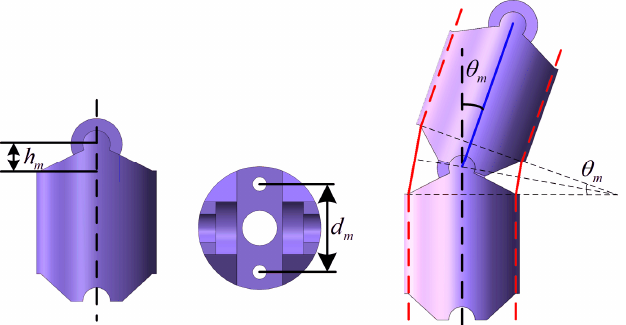
Figure 6. Geometrical analysis of the joints.